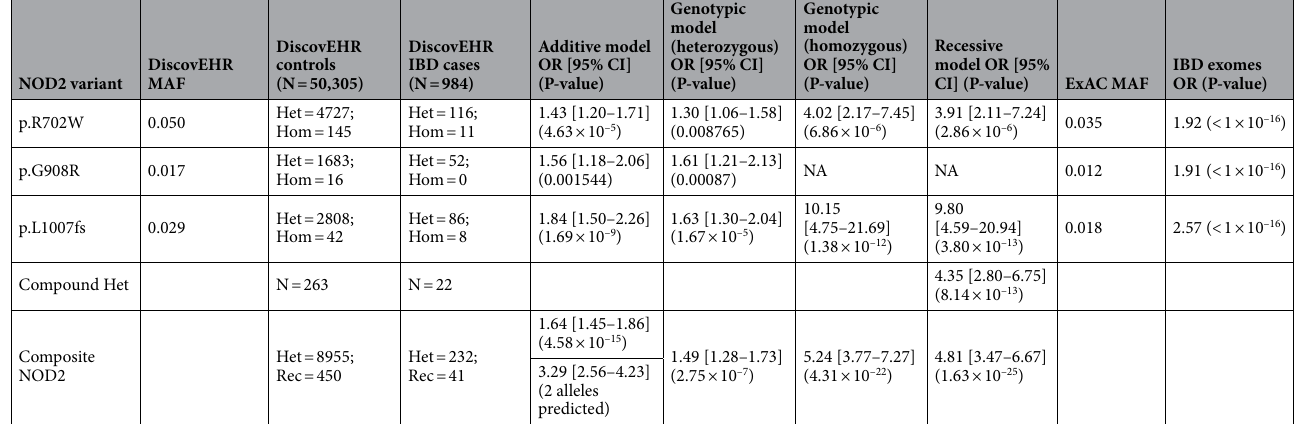
Table 3. OR calculations for 3 NOD2 CD risk alleles (p.R702W, p.G908R, p.L1007fs), composite, and compound heterozygous combinations in the DiscovEHR cohort. There were no homozygotes for the p.G908R variant affected with IBD in our cohort; therefore, no genotypic homozygous and recessive ORs could be calculated. The ‘Composite NOD2 ′ calculations account for all alleles and genotypes for the 3 CD risk variants in the different genetic models.